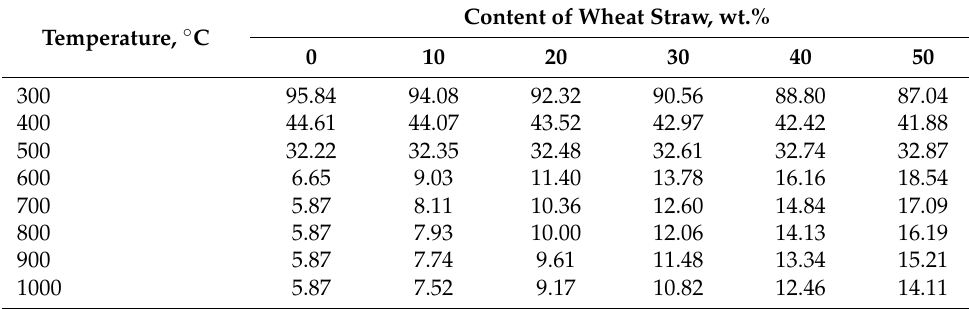
Table 4. Residual weight in composites with wheat straw powder. Temperature, ◦